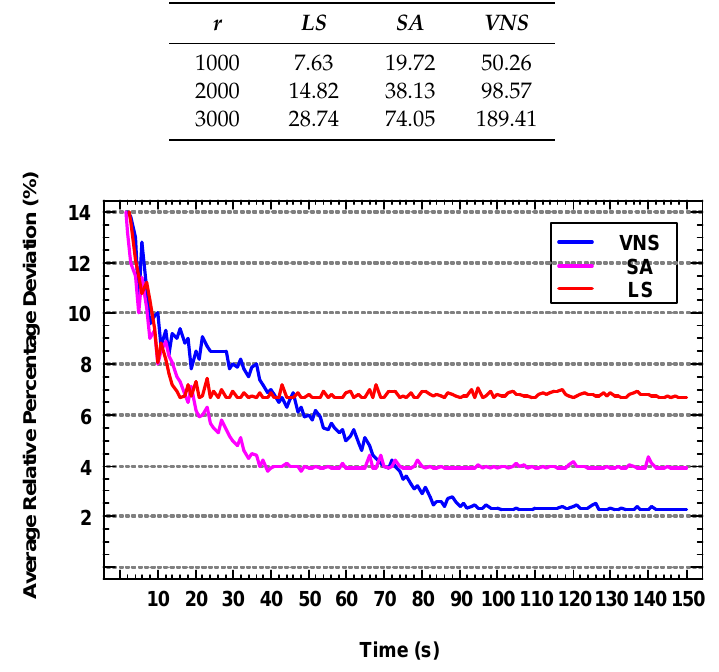
Table 3. Average operation time (s).